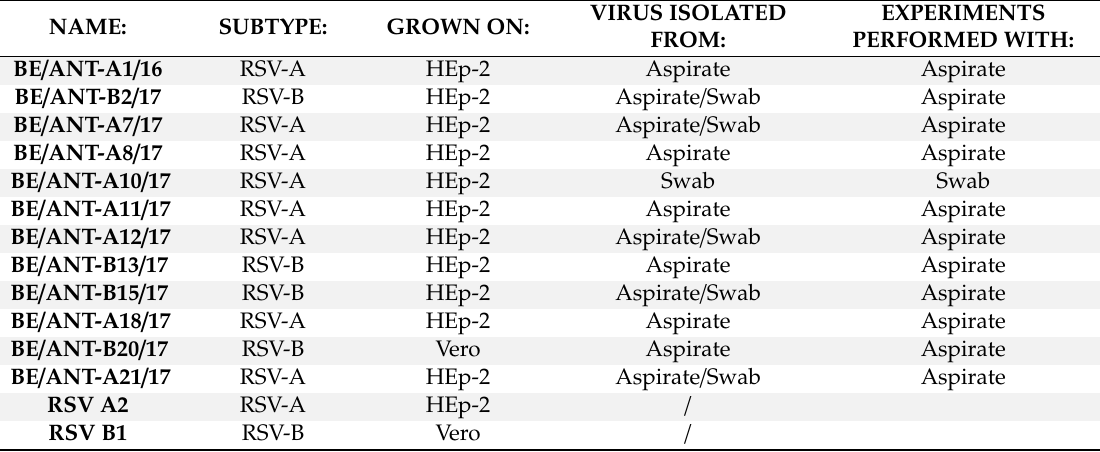
Table 1. Overview of clinical isolates and viruses used in experiments, with subtyping results and cell type used for